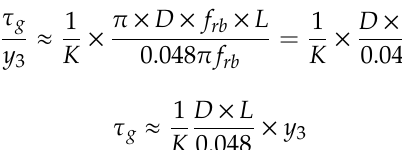
(b) Figure 15. Roadway surrounding rock monitoring curve. Monitoring points ( a ) 1 and ( b ) 2. 7. Conclusions The following conclusions were obtained in this research: (1) The orthogonal design method was used to design the parameter proportioning scheme